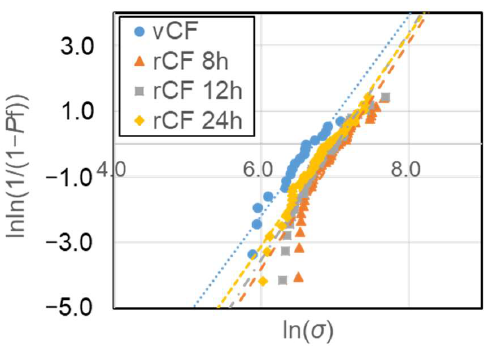
Figure A3. Fiber diameter of carbon fiber measured by SEM.